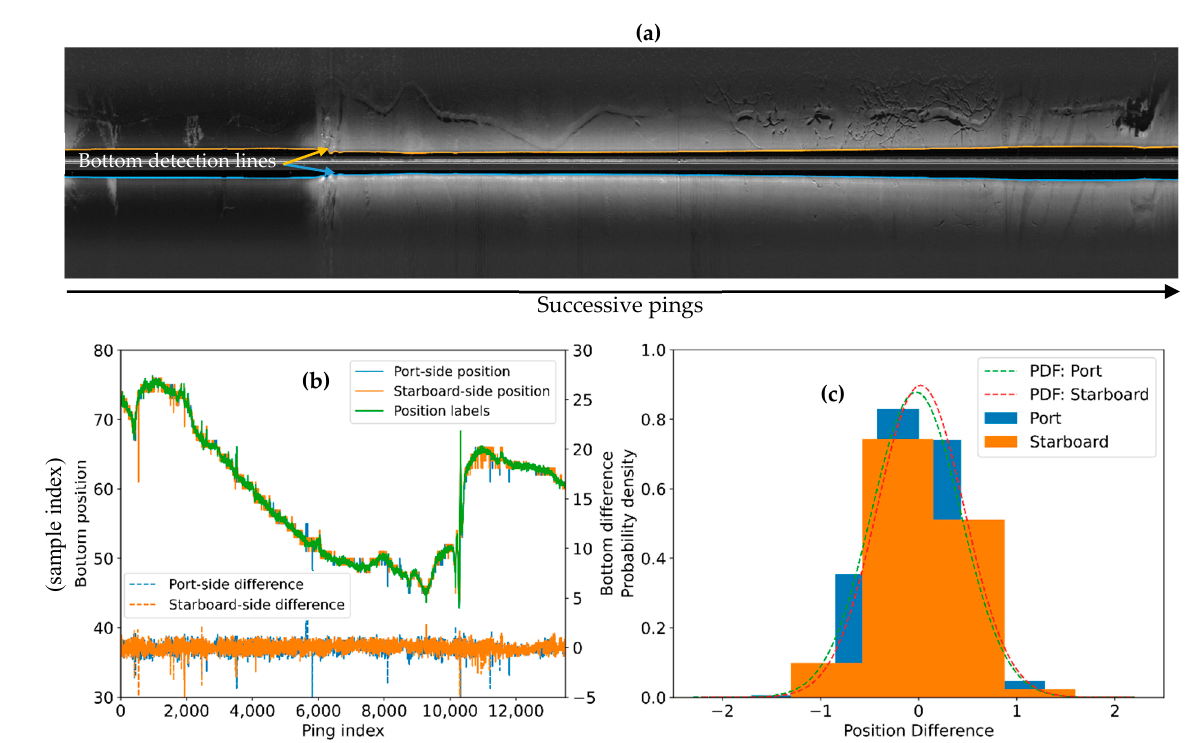
Figure 10. Bottom detection results obtained by using the trained 1D-UNet model. ( a ) shows the detected sea bottom positions of the port-side and starboard-side pings on the side-scan waterfall image; ( b ) shows the comparison and differences between the bottom position labels with the port-side and starboard-side predicted results; ( c ) shows the histograms and fitted probability distribution function (PDF) curves of the position difference data from ( b ).